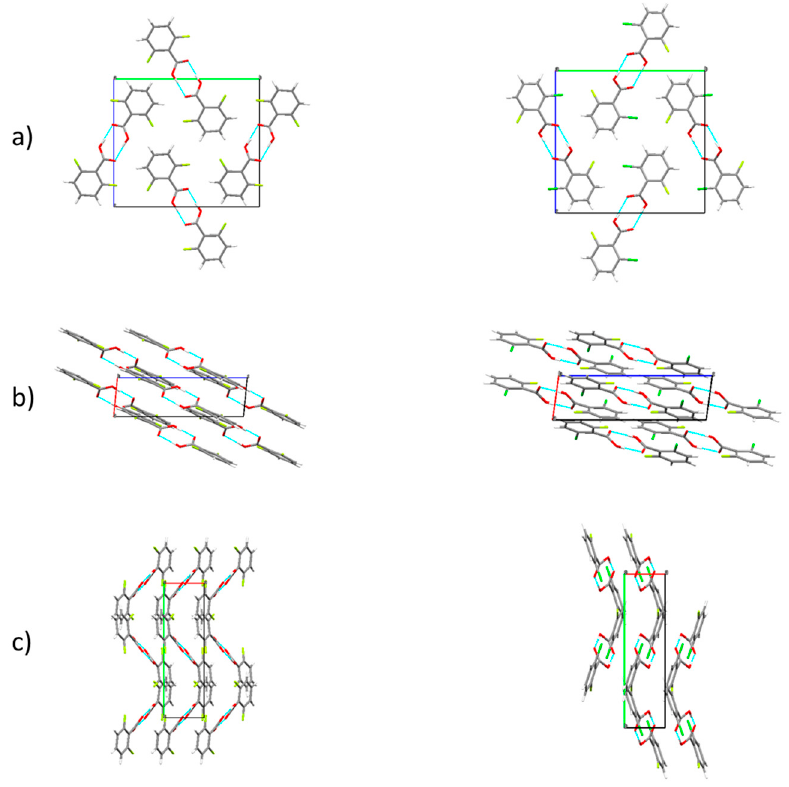
Figure 19. Crystal packing for 26DFBA ( left ) and 2C6FBA ( righ t) as viewed from the a ( top ), b ( middle ) and c ( bottom ) crystallographic axes. Data from [22], and [24], respectively.